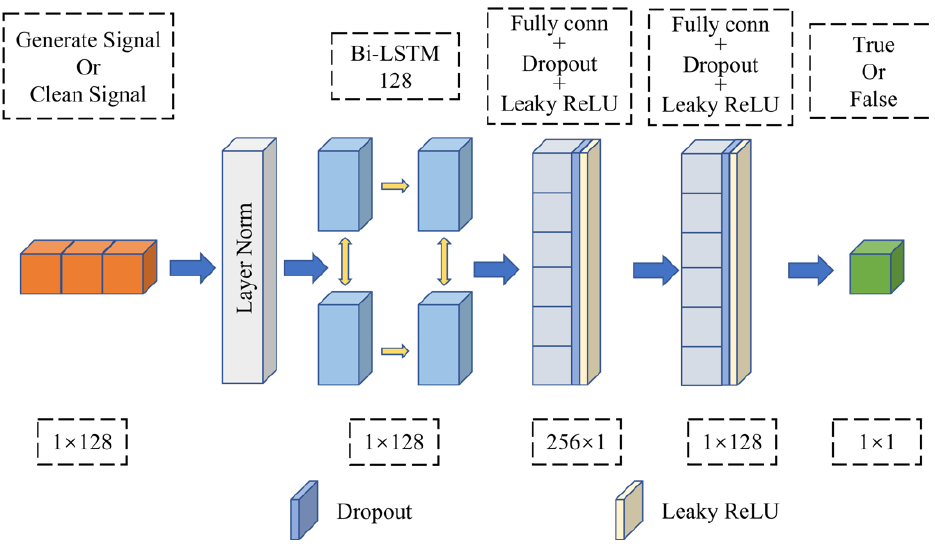
Figure 4. Discriminator network structure.